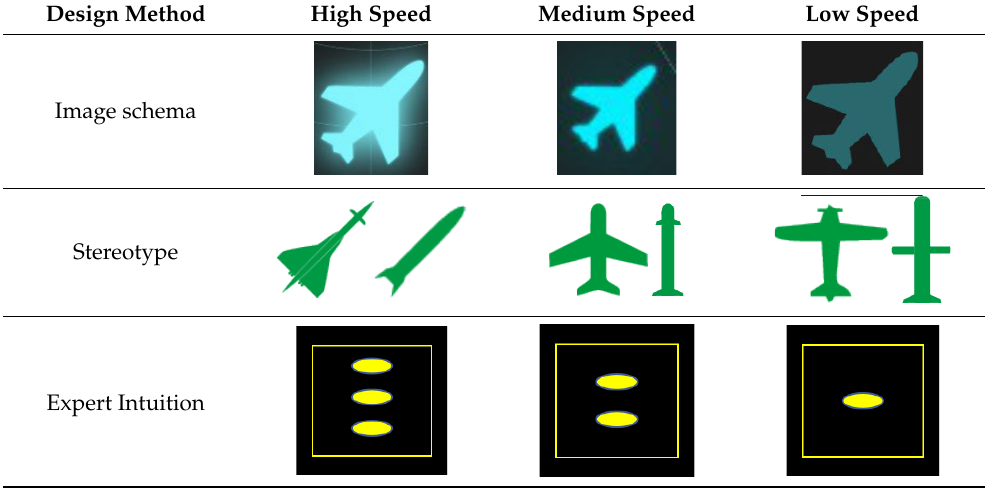
Table 1. Example of speed display design.